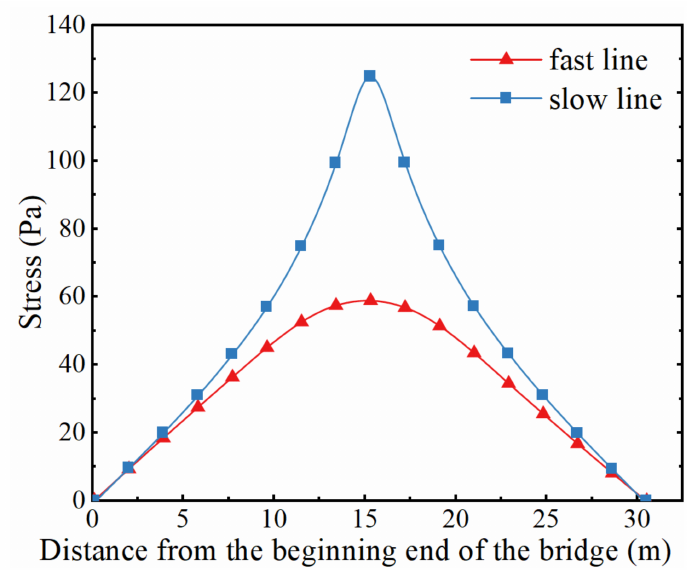
Figure 5. Longitudinal stress influence lines of the fatigue